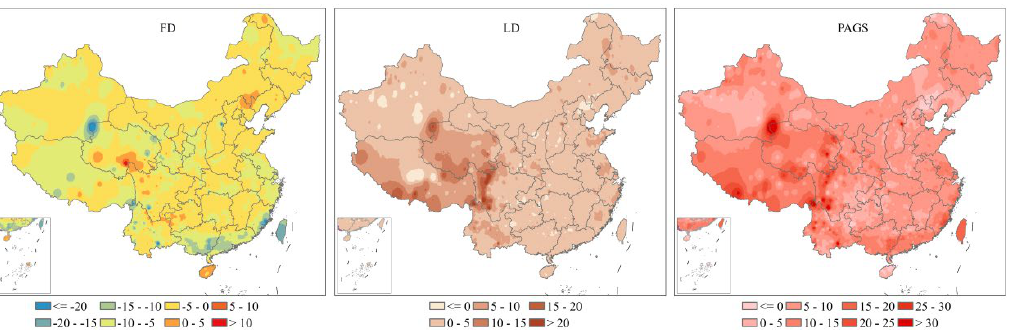
Figure 2. The change of the first date with daily mean air temperature ≥ 10 °C, the last date with daily mean air temperature ≤ 10 °C, and the length of the potential agricultural growing season in 1991–2020 relative to 1961–1990.